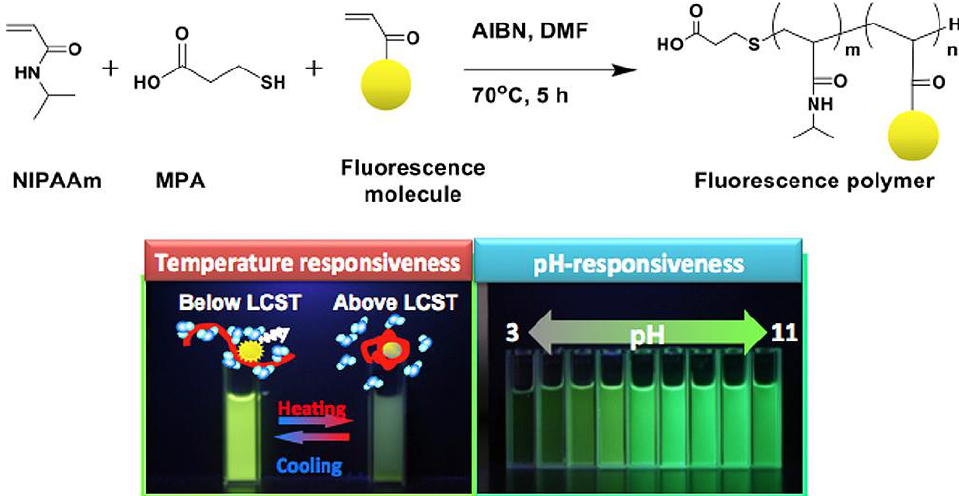
Figure 8. General synthetic scheme for the temperature and pH-responsiveness poly-NIPAAm. Reproduced from reference [82].